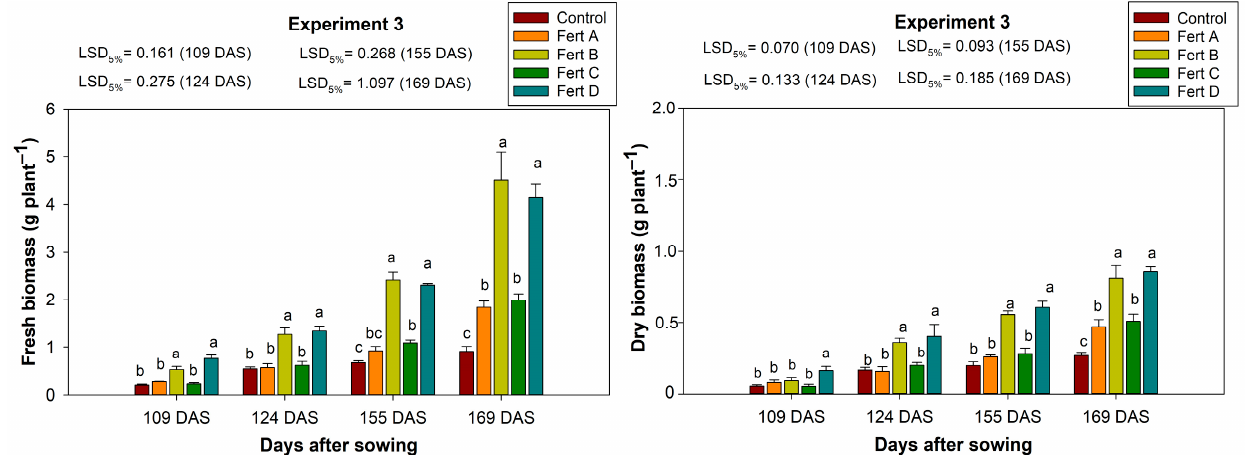
Figure 11. Fresh and dry biomass (g plant − 1 ) of bristly oxtongue as affected by various fertilization regimes. For each sampling date, bars followed by the same letters were not shown to significantly differ with Fisher’s least significant difference (LSD) test. The error bars show the Standard Error values. Final measurement (source of variation: treatments): Fresh biomass: Fvalue = 21.578, p < 0.001, DF (degrees of freedom) = 4 and Rosette diameter: Fvalue = 18.995, p < 0.001, DF = 4.